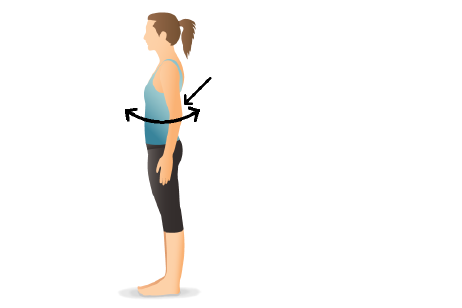
Figure 14. Illustration of the second exercise: lateral rotation of the back (Images provided by Pocket Yoga (www.pocketyoga.com)). The arrow indicates the position of the sensor node.